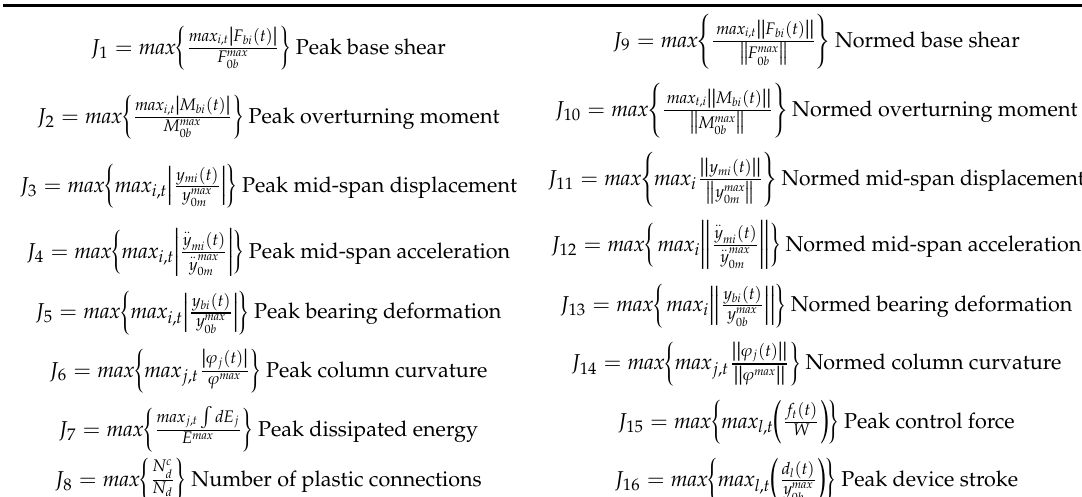
Table 2. Summary of the evaluation